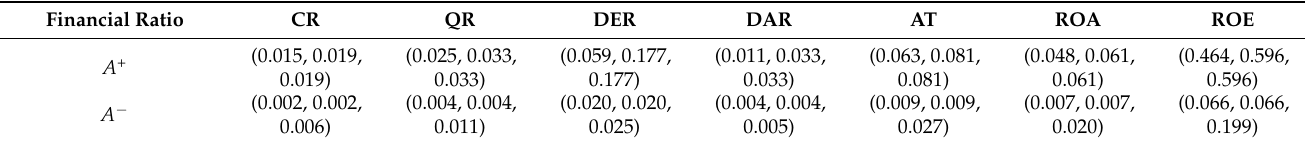
Table 8. The fuzzy PIS ( A + ) and the fuzzy NIS ( A − ).